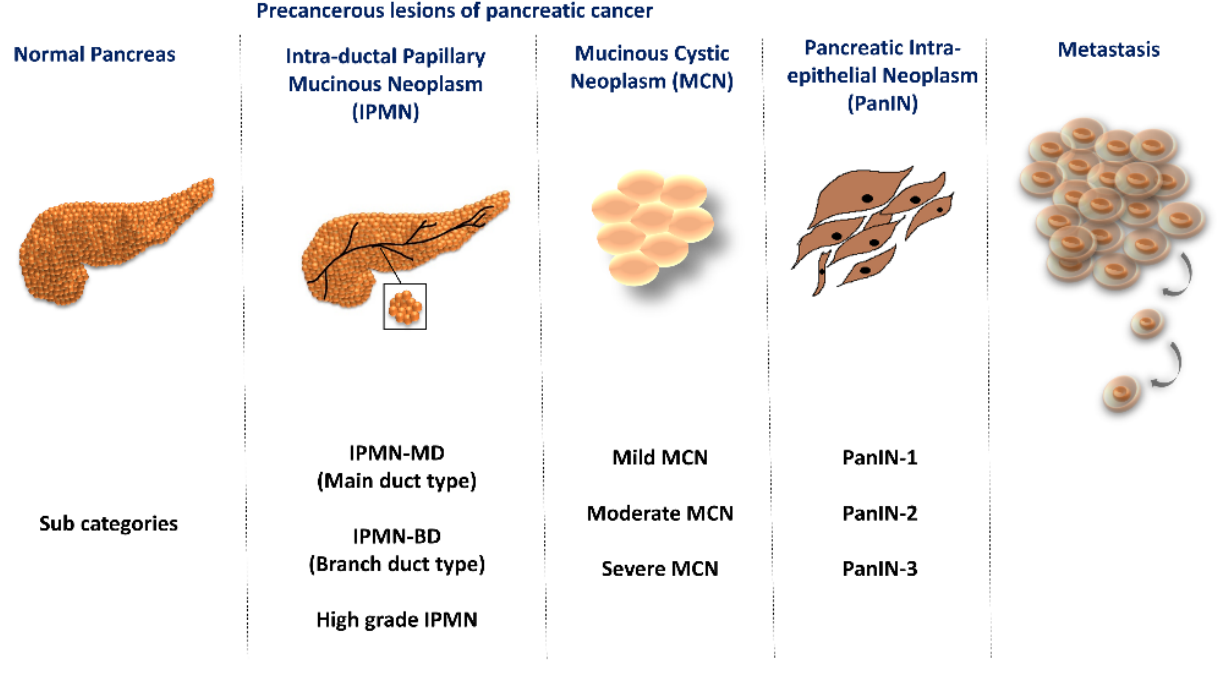
Figure 1. Site of precancerous lesions of pancreatic cancer and their sub-categories.